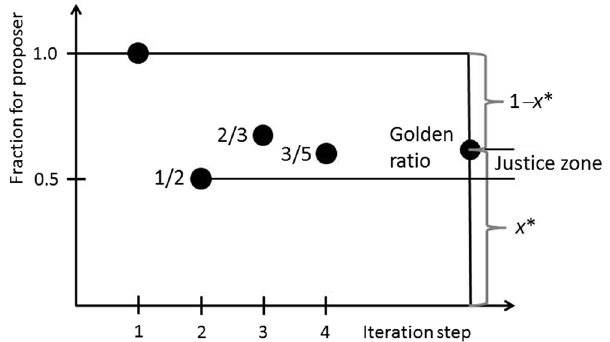
Figure 3. Scheme illustrating the convergence of continued fractions to the inverse Golden Ratio (0.618 … ). The 5 th convergent is 5/8 = 0.625 (not shown), which is already very near the inverse GR. The justice zone suggested by Vermunt 37 and Jasso 36 to be between equipartition and the inverse GR is